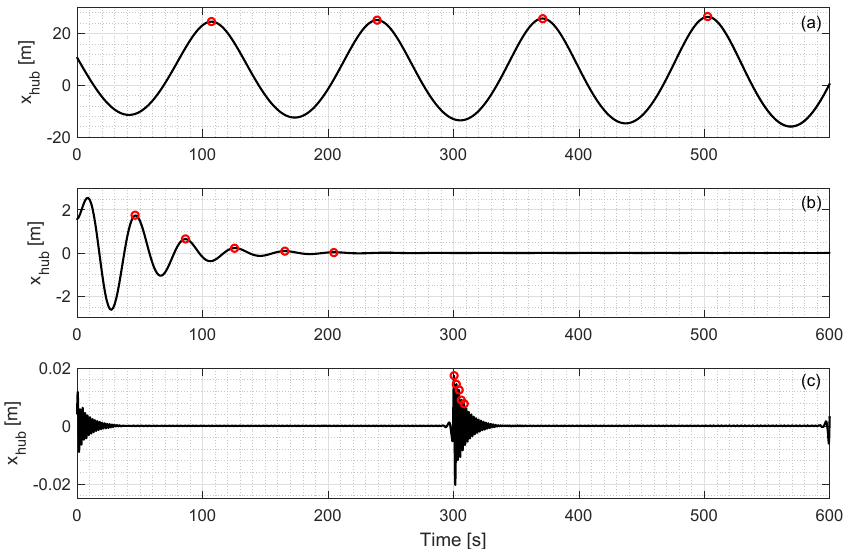
Figure 4. Example of time series of hub position and selected peaks for the extraction of aerodynamic damping. From top to bottom: surge, pitch and clamped tower